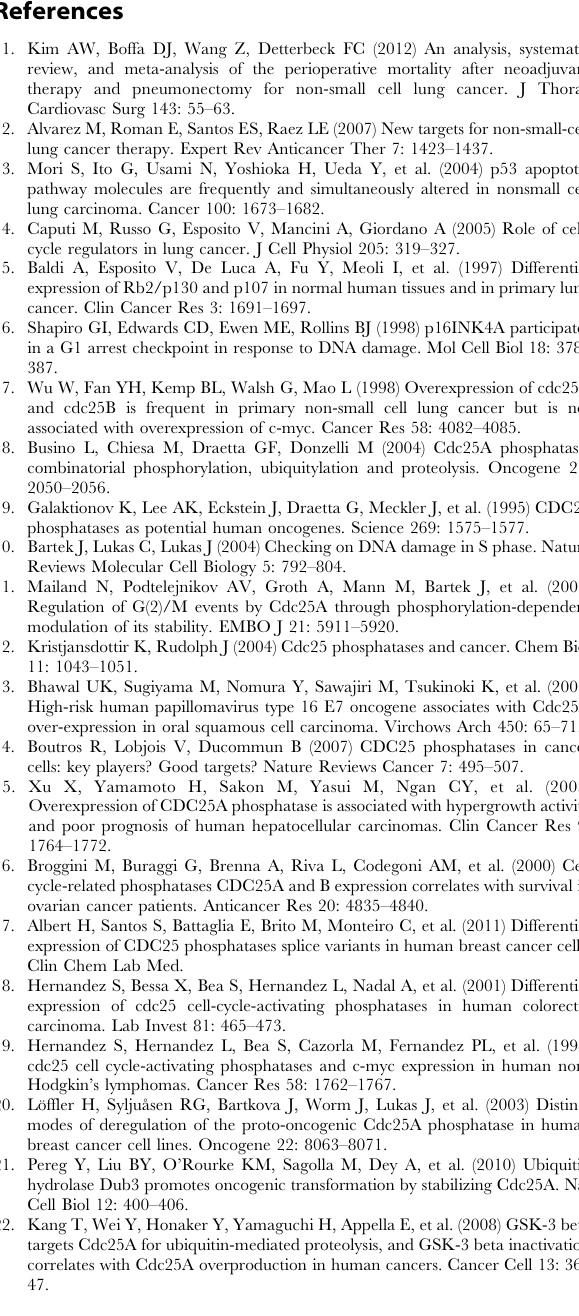
Table S1 CDC25A cDNA clones retrieved from NSCLC cell lines. Table S2 CDC25A Q110del expression in NSCLC tumor tissue and overall survival. Table S3 Tumor CDC25A Q110del expression and demographic variables. (DOCX)